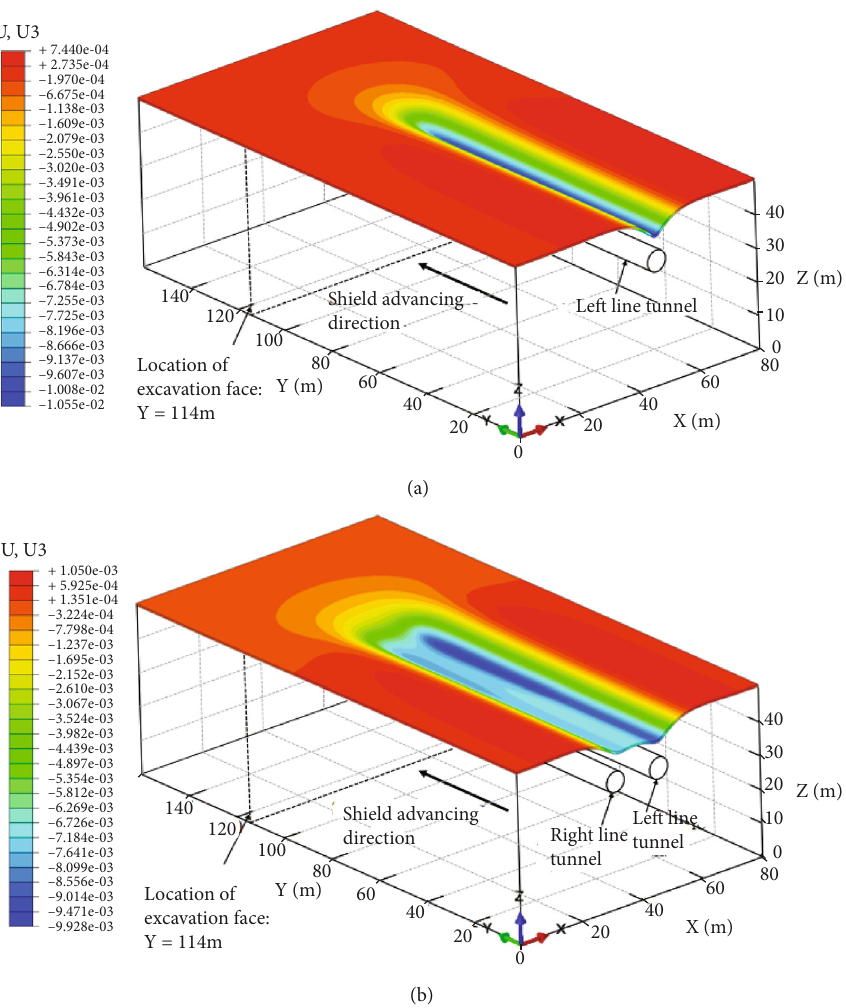
Figure 5: Surface settlement on: (a) left line and (b) right